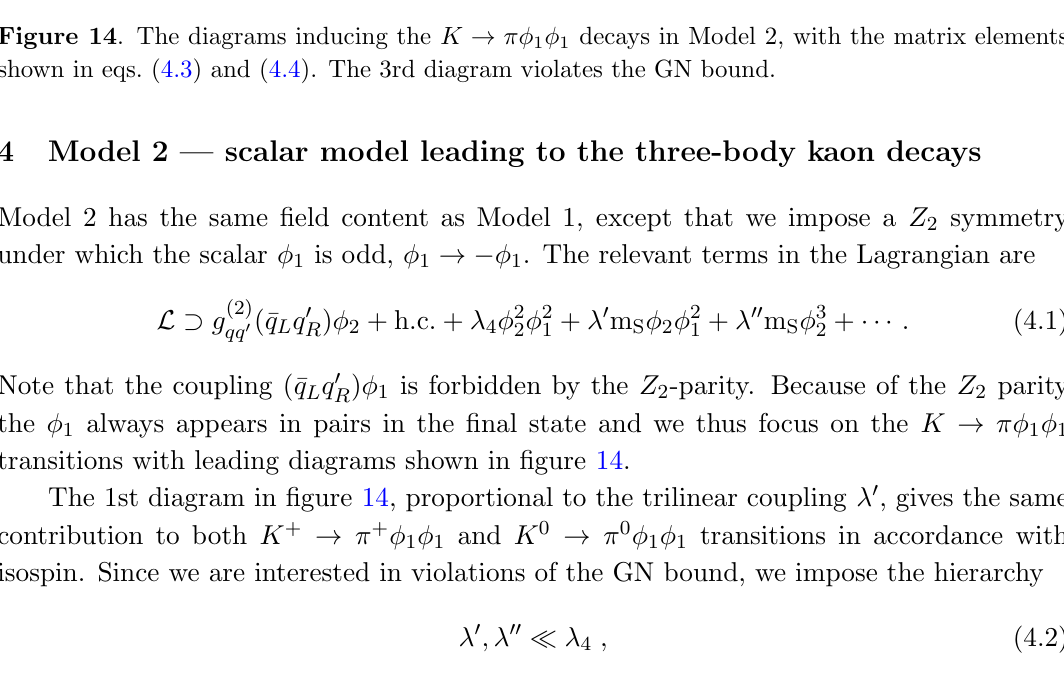
(cid:25)(cid:30) 1 (cid:30) 1 decays in Model 2, with the matrix elements !